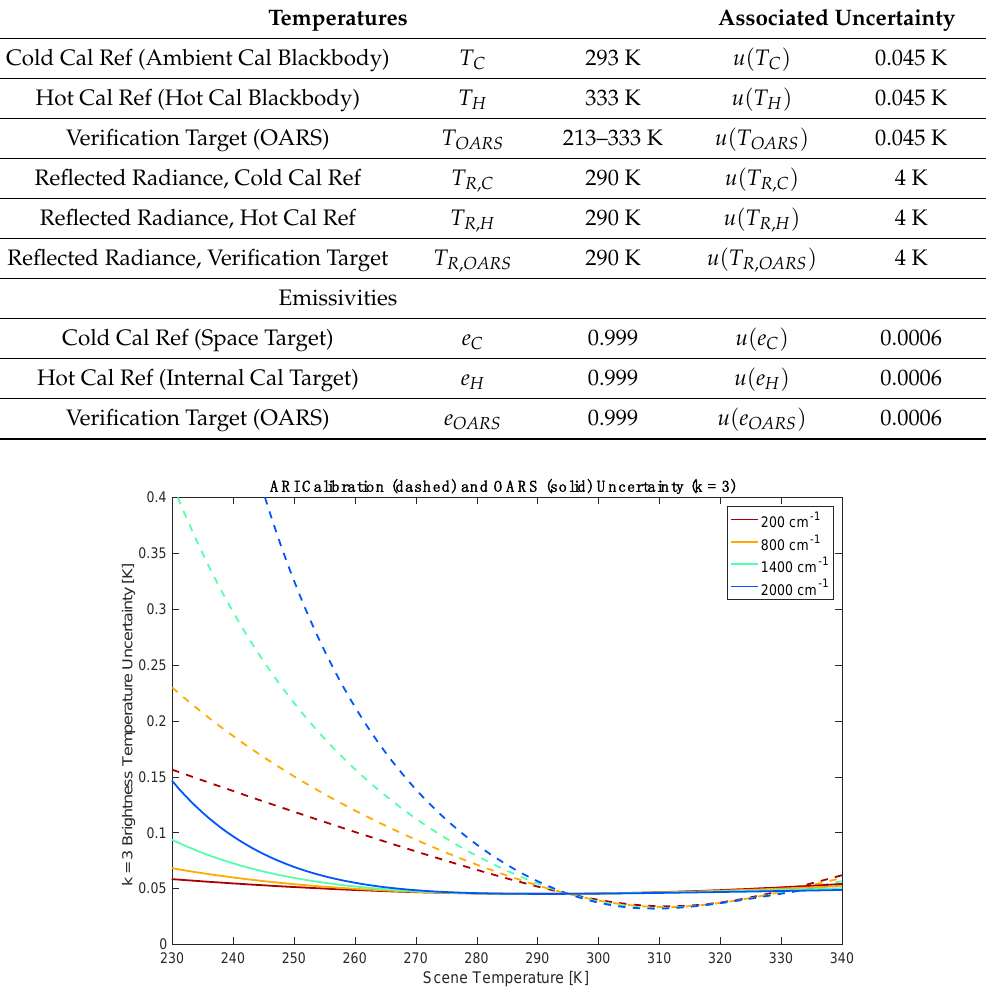
Figure 7. Predicted laboratory radiometric calibration uncertainty (dashed) and calibration verification source uncertainty (solid) (k = 3).